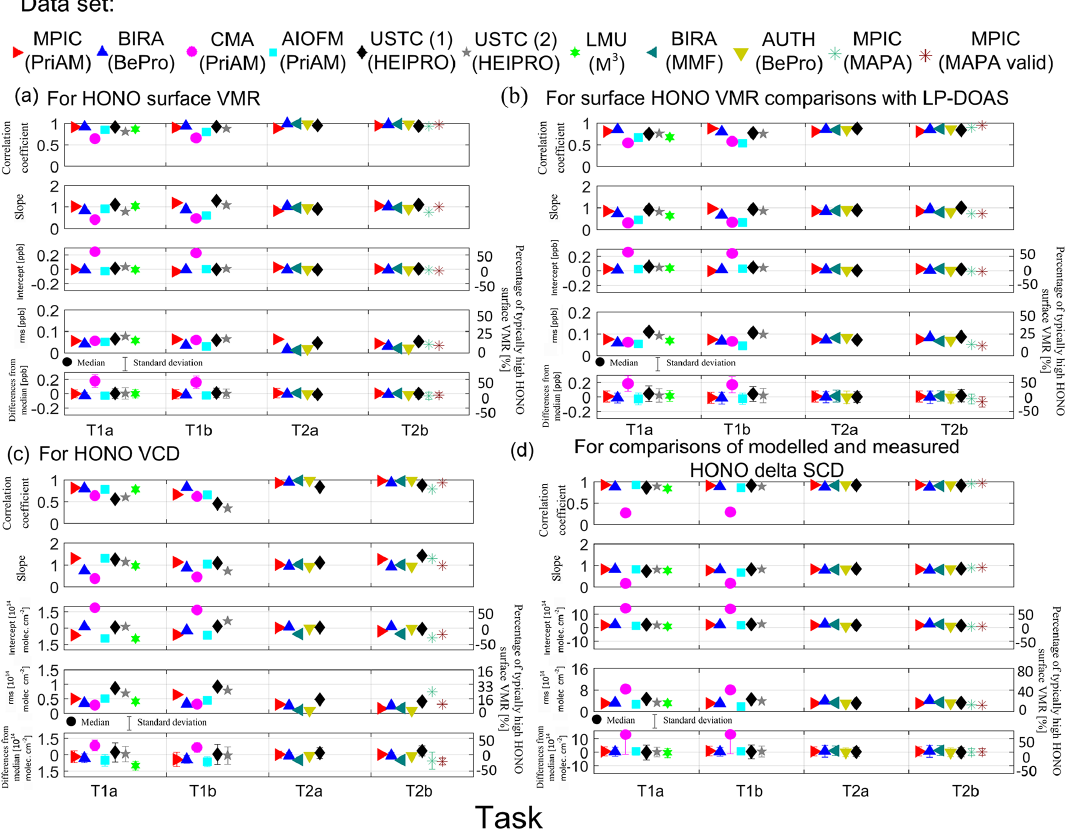
Figure 7. Correlation coefficients, slopes, intercepts, and rms of the residuals of the linear regression as well as median differences between individual participants and the reference values, which are the median values of all MAX-DOAS (a, c) , and of the co-located LP-DOAS measurements (b) . Comparisons of the near-surface HONO VMRs are given in (a) and (b) . Comparisons of HONO VCDs are given in (c) . For the individual data sets, the same comparison parameters are derived for the comparison of measured and modelled HONO delta SCDs (d)